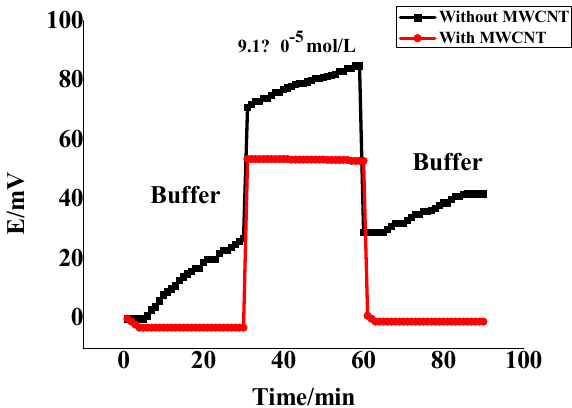
Figure 7. Water-layer tests for the FLX-ISE with and without MWCNT as the solid contact.